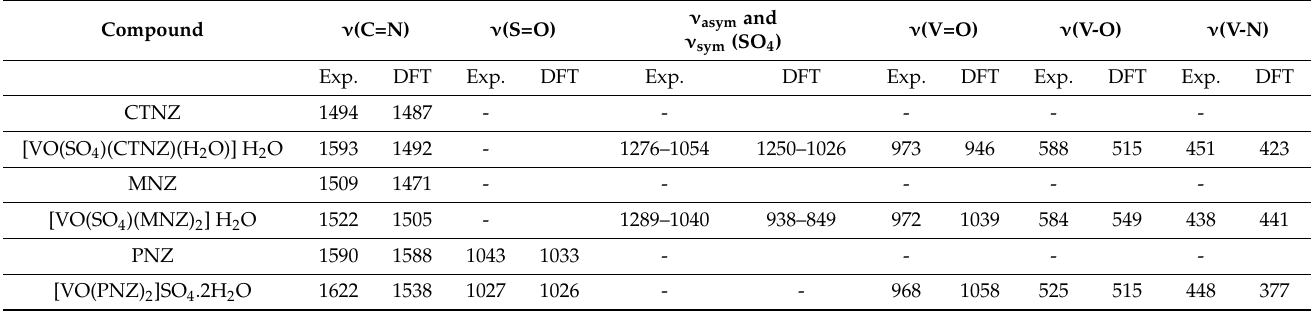
Table 3. The main bands in IR spectra for ligands and their oxidovanadium(IV)